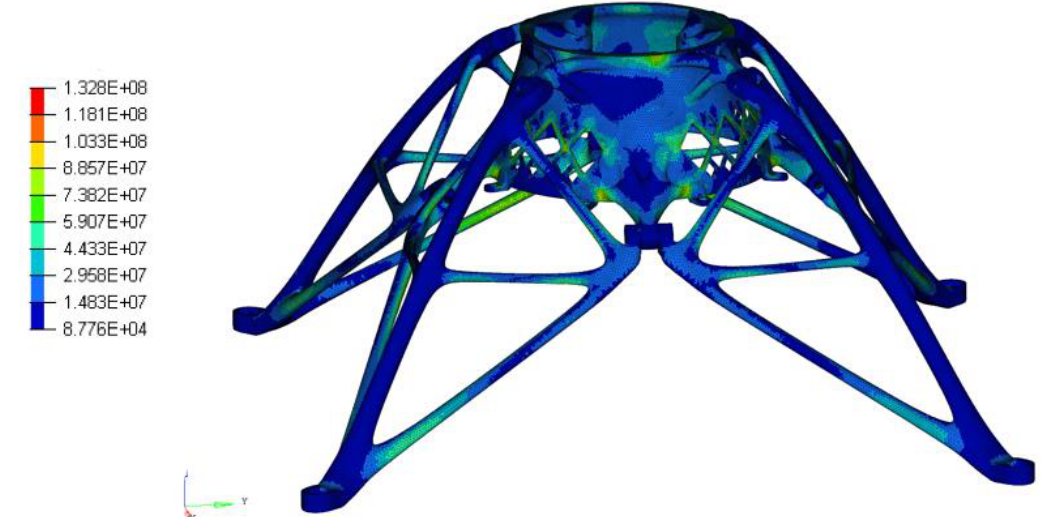
Figure 19. Results of the FEM analysis: Stress plot of the complete engine mount structure subjected to x/y excitation.